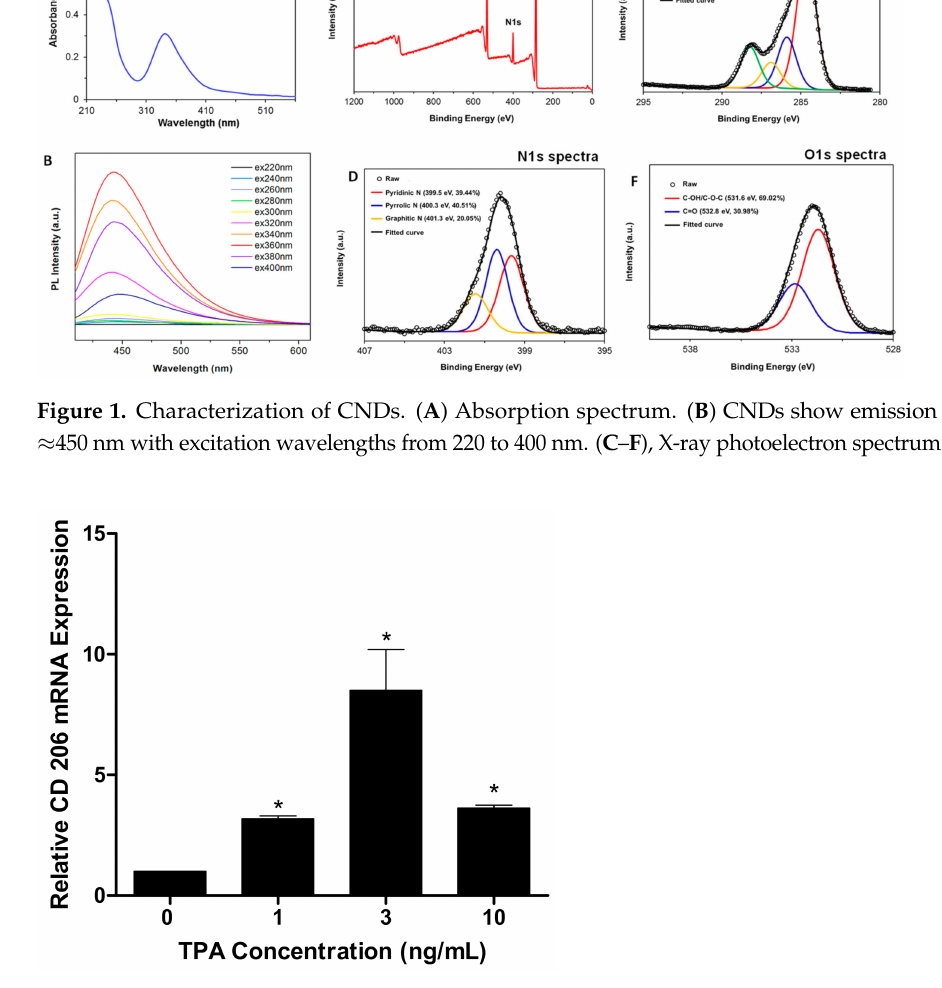
Figure 2. Increase in CD206 expression in THP-1 human monocyte-derived macrophages. THP-1 cells (3.3 × 10 6 ) were treated with 0, 1, 3, and 10 ng/mL of 12-O-tetradecanoylphorbol 13-acetate (TPA) in RPMI media for 72 h, upon which media was refreshed. Then, cells were left to incubate and mature for another 72 h. RNA was isolated, converted to cDNA, and probed for CD206 using SYBR green qRT-PCR reagents via Biosystems™ StepOnePlus™ Software v2.3. GAPDH was the housekeeping gene. All data represent mean ± SEM. ( n = 3, *, p < 0.05 vs.